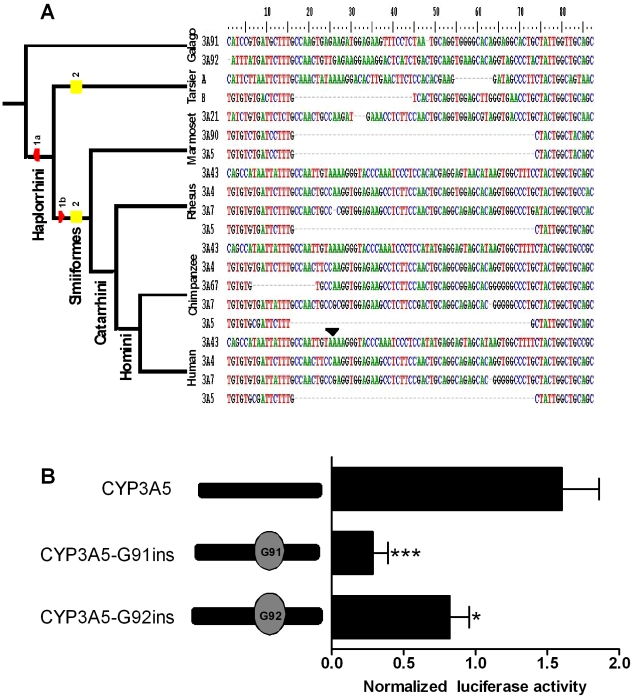
Genomic and functional conservation of the 57 bp CYP3A promoter region in primates.(A) Representation of the evolution of the 57 bp region. Deletions are shown as stretch of hyphens, with the widest one corresponding to the deletion of the entire 57 bp region. 1a–b and 2 indicate the two alternative scenarios of the 57 bp deletion. “CYP” has been removed from gene names to improve legibility. A 7 bp fragment present only in all CYP3A43 genes has been removed for clarity and it position in the human CYP3A43 gene is indicated by an arrow. (B) The effect of galago CYP3A91- and CYP3A92-derived 57 bp regions on the human CYP3A5 promoter activity in MDCK.2 cells. Data are expressed as mean values (±SEM) of five independent experiments conducted as triplicates. Promoter-driven firefly luciferase activities in the individual wells were normalized using activities of the co-transfected renilla luciferase driven by a constitutive promoter. Statistically significant differences are indicated by asterisks *p<0.05, ***p<0.001.